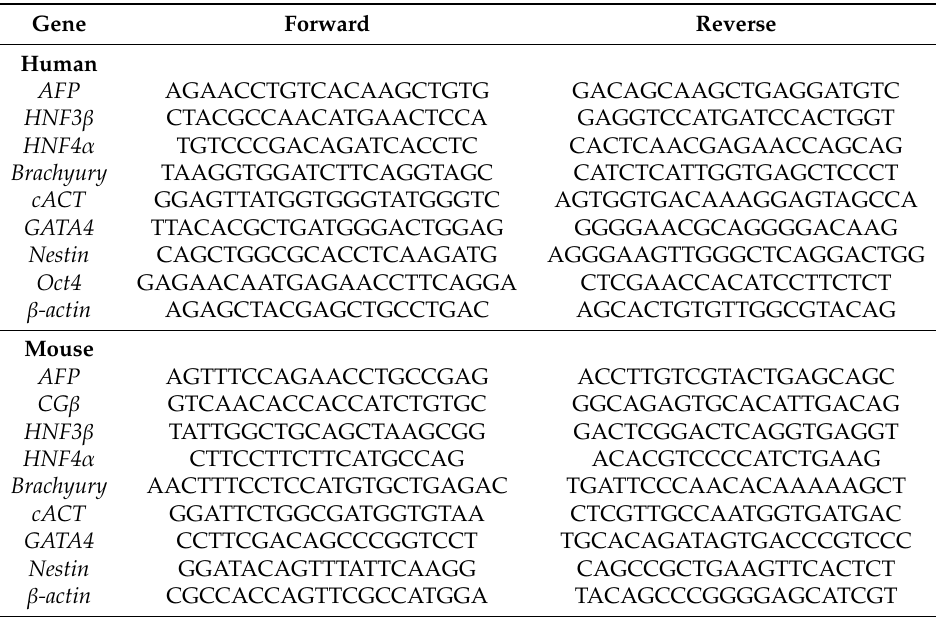
Table 2. The sequence of primers used for